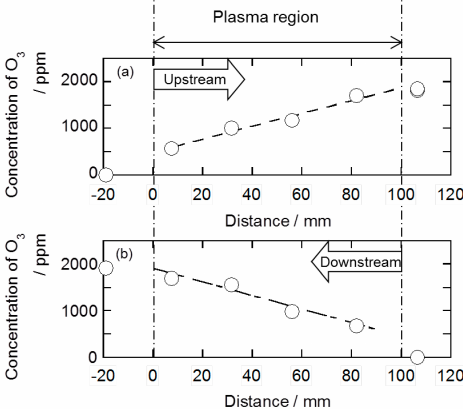
Figure 3. Ozone distribution in a conventional plasma reactor: ( a ) upstream configuration and ( b ) downstream